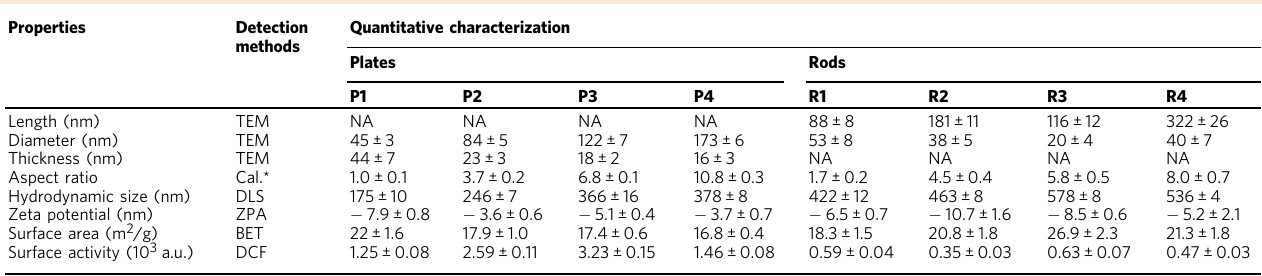
Table 1 Quantitative characterization of Fe 2 O 3 nanoparticles Properties